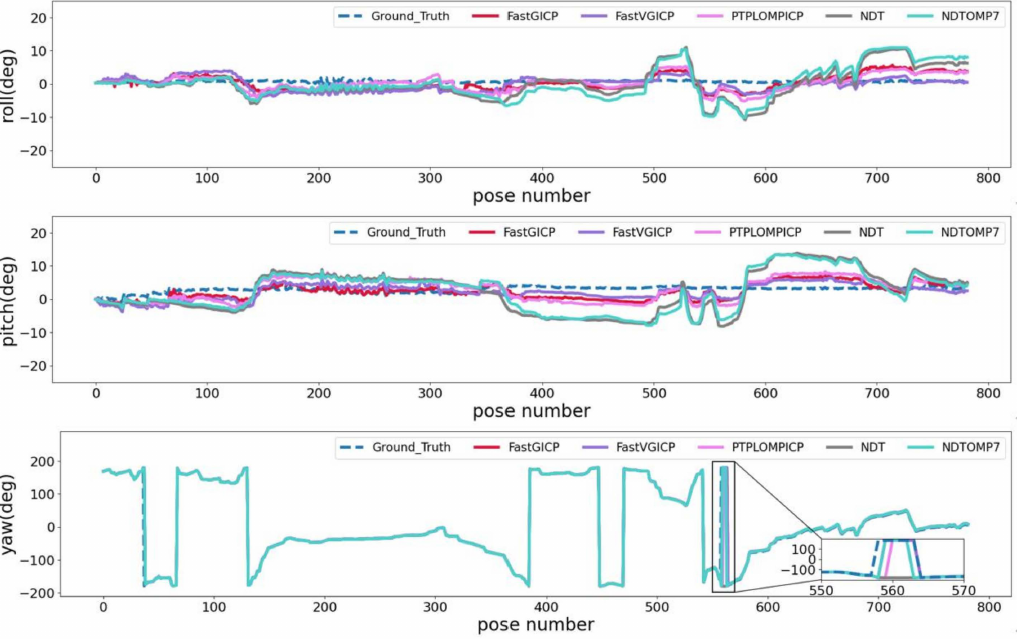
Figure 6. Comparison of output pose Euler angles of registration